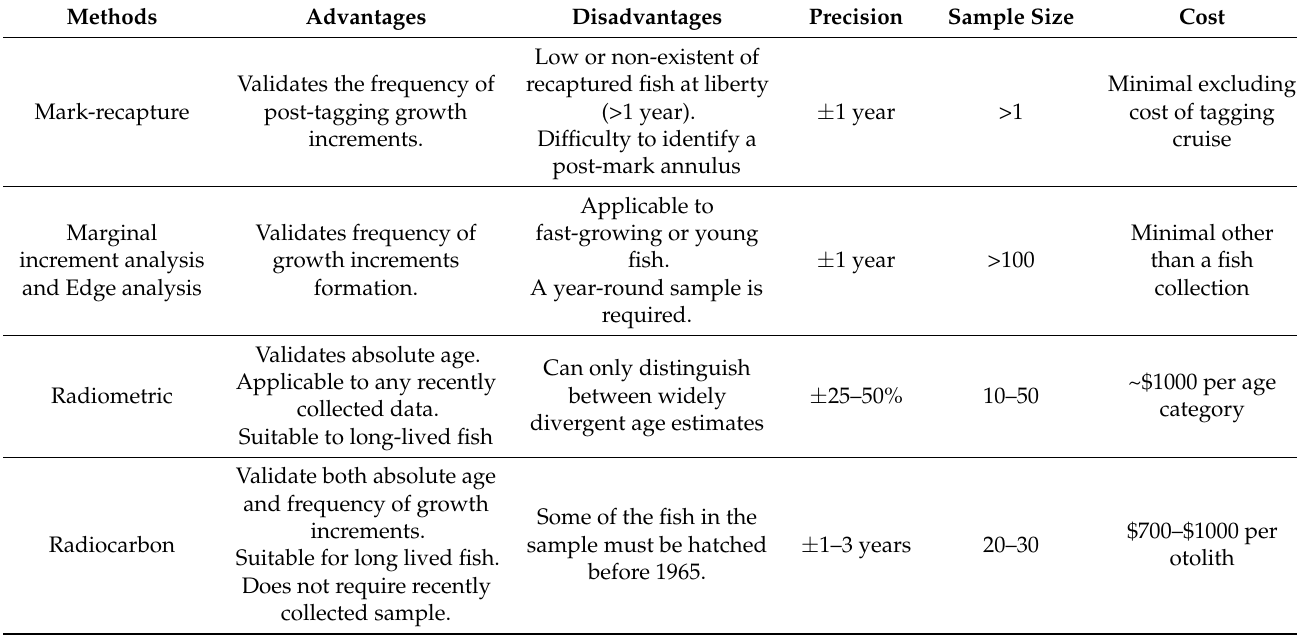
Table 2. Advantages, limitations, precision, sample size and cost of the different methods used to validate age or the rate of growth zone deposition. Methods are listed regardless of any scientific value. (Source: